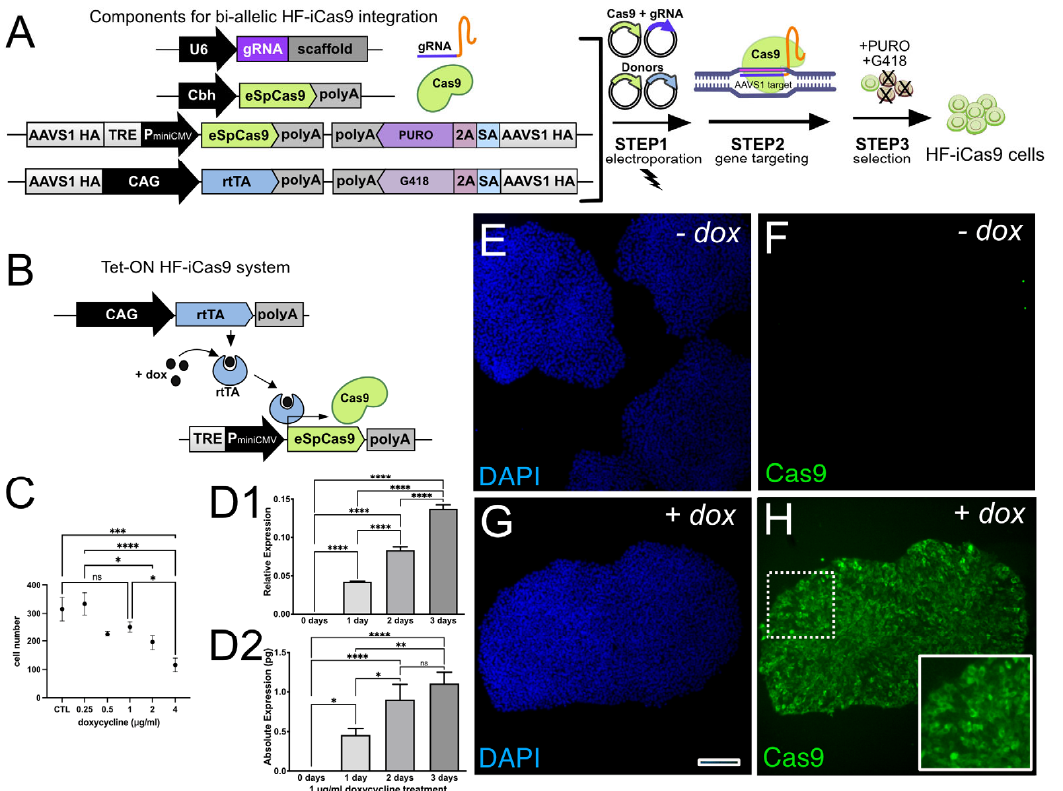
Figure 1. Development of Tet ‐ inducible high ‐ fidelity HF ‐ iCas9 expressing cell lines. A platform for gene editing was devised by generating HF ‐ iCas9 hPSC lines that incorporated a ( A ) plasmid car ‐ rying a U6 promoter for transient expression of an AAVS1 guide RNA (gRNA) and eSpCas9, and plasmids for biallelic integration of Tet ‐ inducible eSpCas9 and constitutive reverse tetracycline ‐ con ‐ trolled trans ‐ activator (rtTA) both at separate alleles at the AAVS1 SHS. A promoter ‐ less splice ac ‐ ceptor (SA) site linked to the p2A sequence allows for the integration of the cassette within the intron of AAVS1 reducing chances of random integration. ( B ) A diagram highlighting the 3G Tet ‐ On sys ‐ tem for inducible HF ‐ iCas9 that is activated upon binding of rtTA/dox to a tetracycline response element (TRE). ( C ) Assessment of the influence of dox concentration on cell proliferation. ( D1 , D2 ) Normalized relative (top) and absolute (bottom) expression of Cas9 measured by qRT ‐ PCR after 0 to 3 days of dox (1 μ g/mL). At day 0, the expression of Cas9 was undetectable. ( E – H ) Immunostain ‐